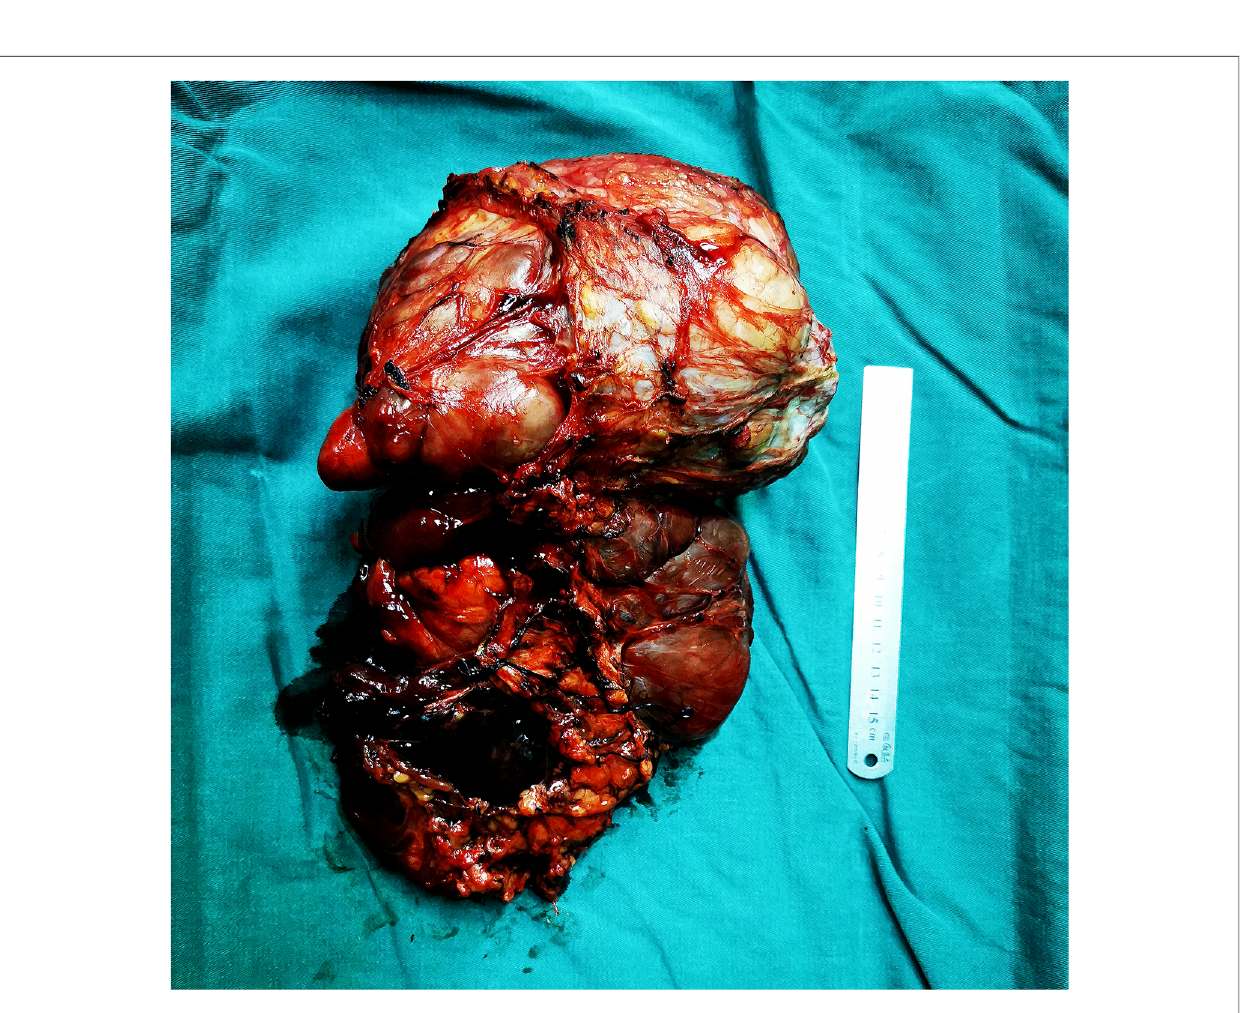
FIGURE 3 During the surgery, a tumor with a size of about 20 cm×18 cm in the groin and scrotum was found, with a tough texture and a cystic mass, which was adhered to the surrounding tissues. After electrocoagulation with Ligsaure and separation, the tumor was completely